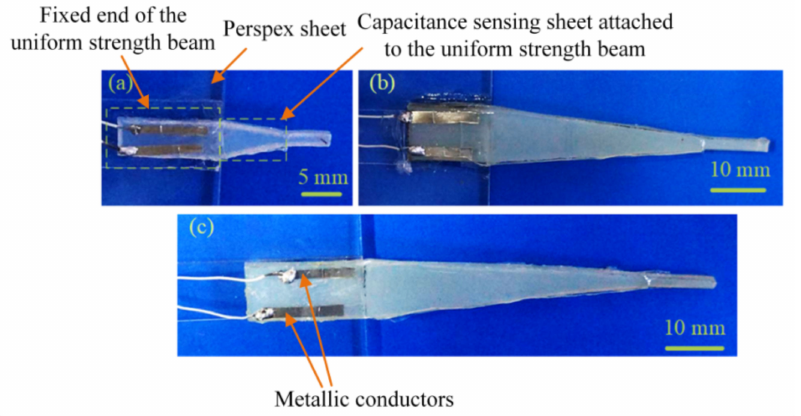
Figure 5. Tactile sensor samples, where ( a ) is No.1 sensor, ( b ) is No.2 sensor, and ( c ) is No.3 sensor.